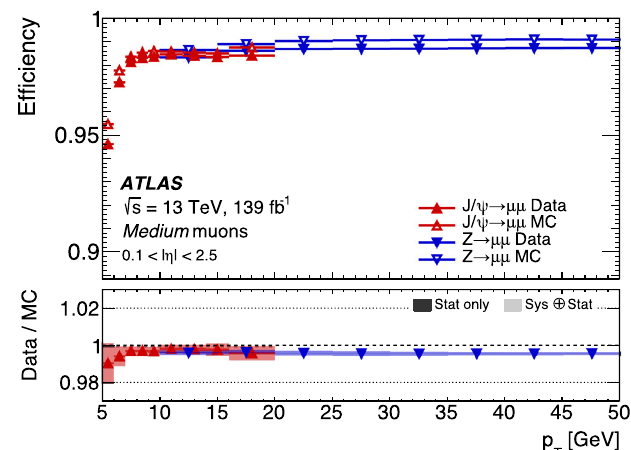
Fig. 13 Muon reconstruction and identification efficiencies for the Medium criteria measured in J /ψ → μμ and Z → μμ events as a function of p T for muons with 0 . 1 < | η | < 2 . 5. When not negligible,